Question: Does the plotted quantity increase or decrease?
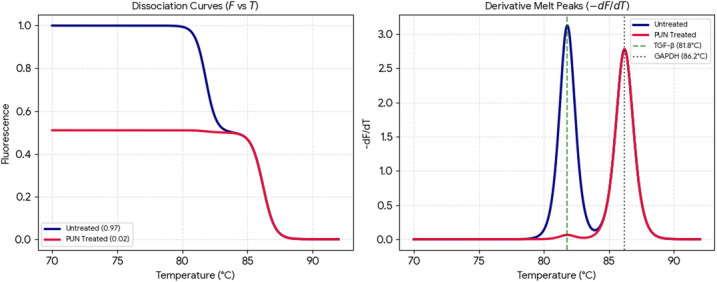
Answer: increasing